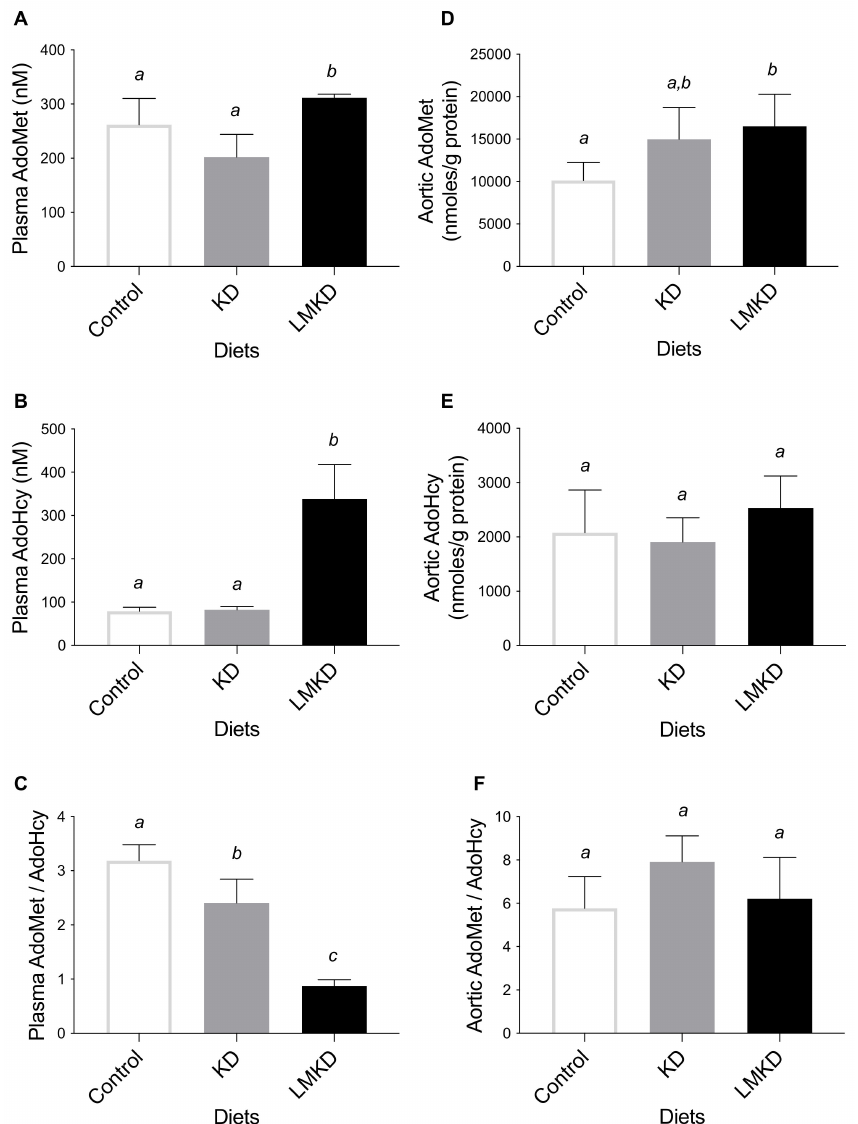
Figure 3. The effect of the experimental diets (ketogenic diet, KD; low methyl ketogenic diet, LMKD; and control) on the concentrations of plasma S-adenosylmethionine (AdoMet) ( A ), S-adenosylhomocysteine (AdoHcy) ( B ) and AdoMet/AdoHcy ratio ( C ), as well as of aortic AdoMet ( D ), AdoHcy ( E ) and AdoMet/AdoHcy ratio ( F ). Data shown are the mean ± SD, n = 4–6/group. Bars not sharing superscript letters differ by p <